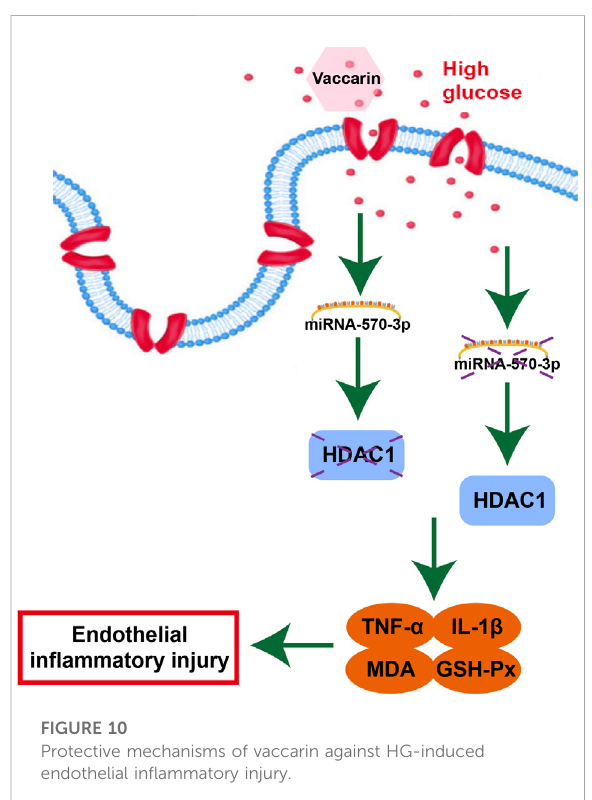
Protective mechanisms of vaccarin against HG-induced endothelial in fl ammatory